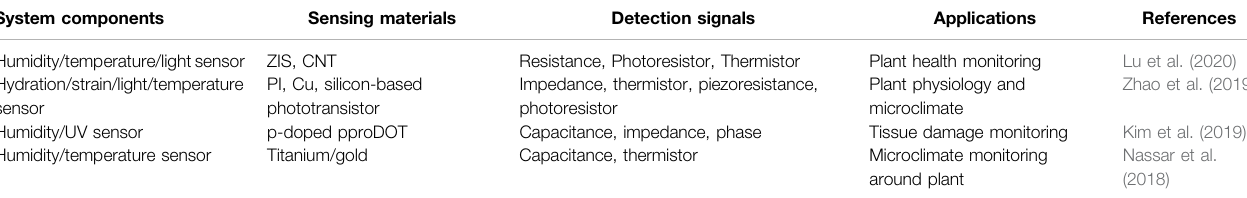
TABLE 4 | Multi-detection plant